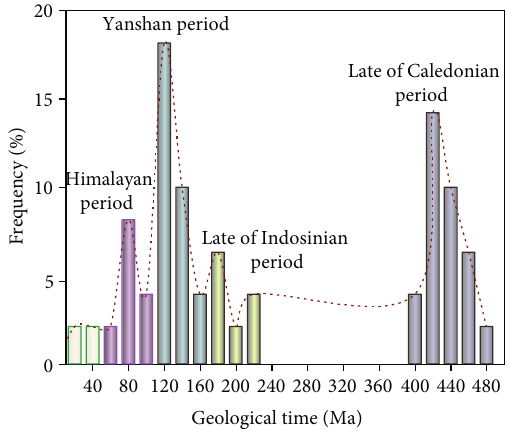
Figure 2: Frequency distribution of tectonic movement in northern